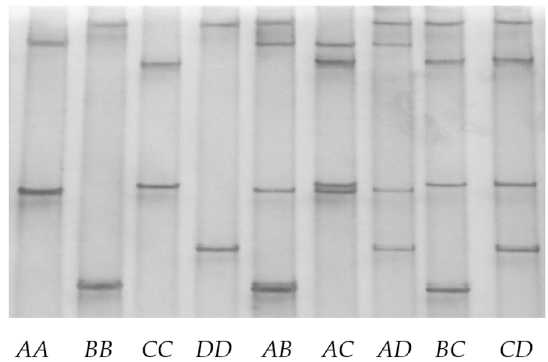
Figure 2. Variation in ovine keratin-associated protein 2-1 gene detected with polymerase chain reaction–single strand conformation polymorphism analysis. Four different banding patterns representing four variants (A–D) are shown in either homozygous (AA, BB, CC and DD) or heterozygous (AB, AC, AD, BC and CD) forms.